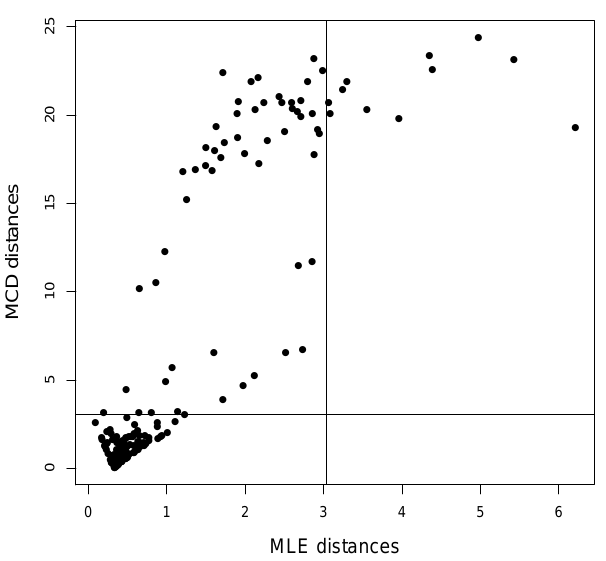
Figure 9. Protein data. Distance-distance plot stemming from the reweighted MCD. The horizontal and vertical lines give the χ 2 quantile. 2;0.99